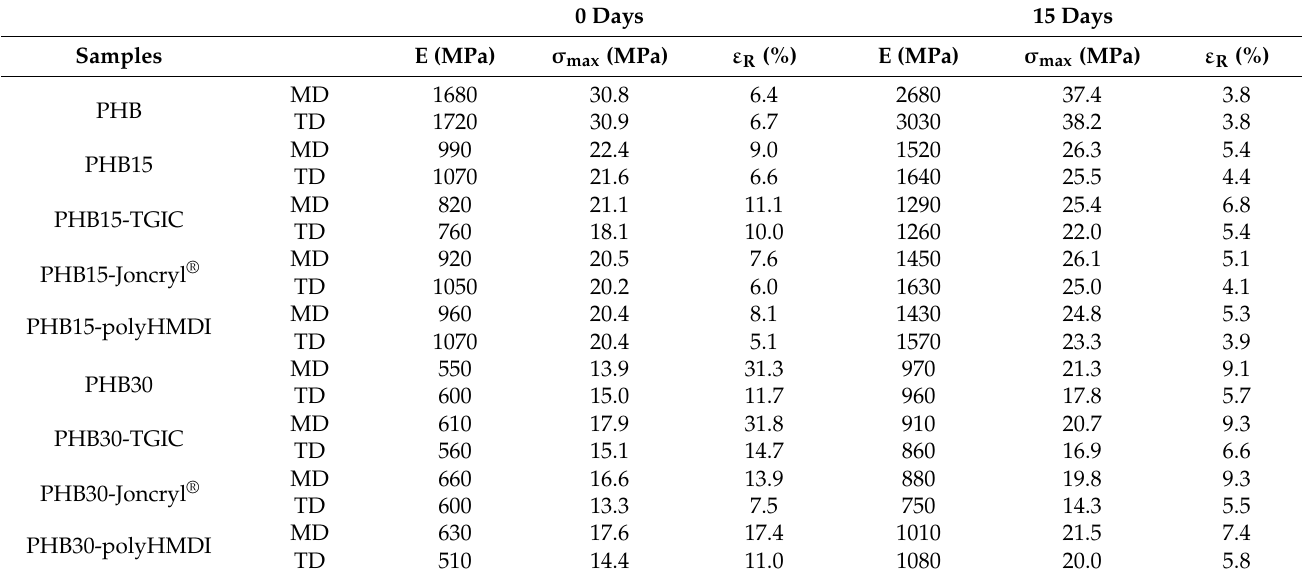
Table 2. Tensile test parameters of the blends with the addition of the reactive agents, at 0 and 15 days of aging. 0 Days 15